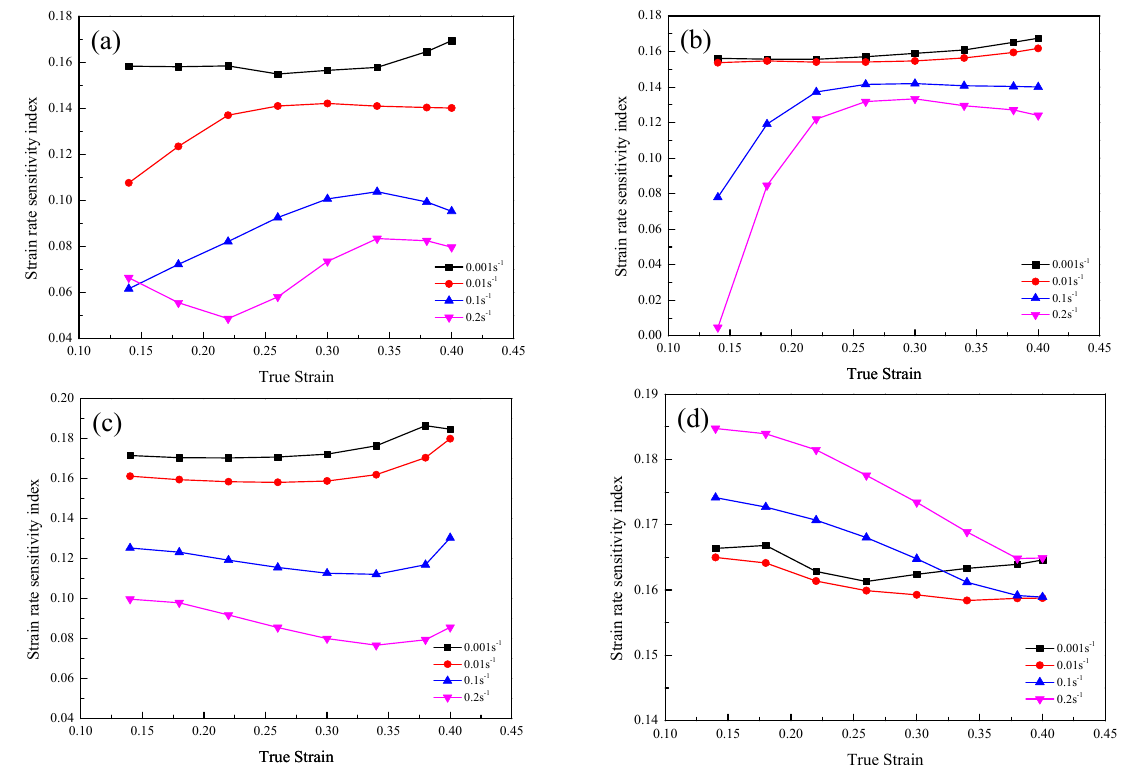
Figure 4. Strain rate sensitivity index of the GH3230 superalloy double-sheet deformed under different deformation temperatures: ( a ) 1123 K; ( b ) 1173 K; ( c ) 1223 K; ( d ) 1273 K.